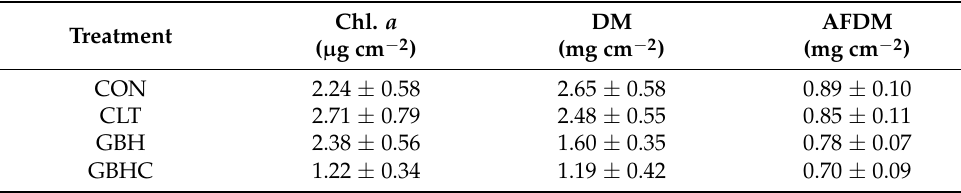
Table 2. Areal biomass measures including chlorophyll (Chl. a ), dry mass (DM), ash-free dry mass (AFDM), 4.5 days after end of exposure to a short-term (12 h) herbicide pulse compared to control treatments not exposed to herbicide; values are means ± SE, n =